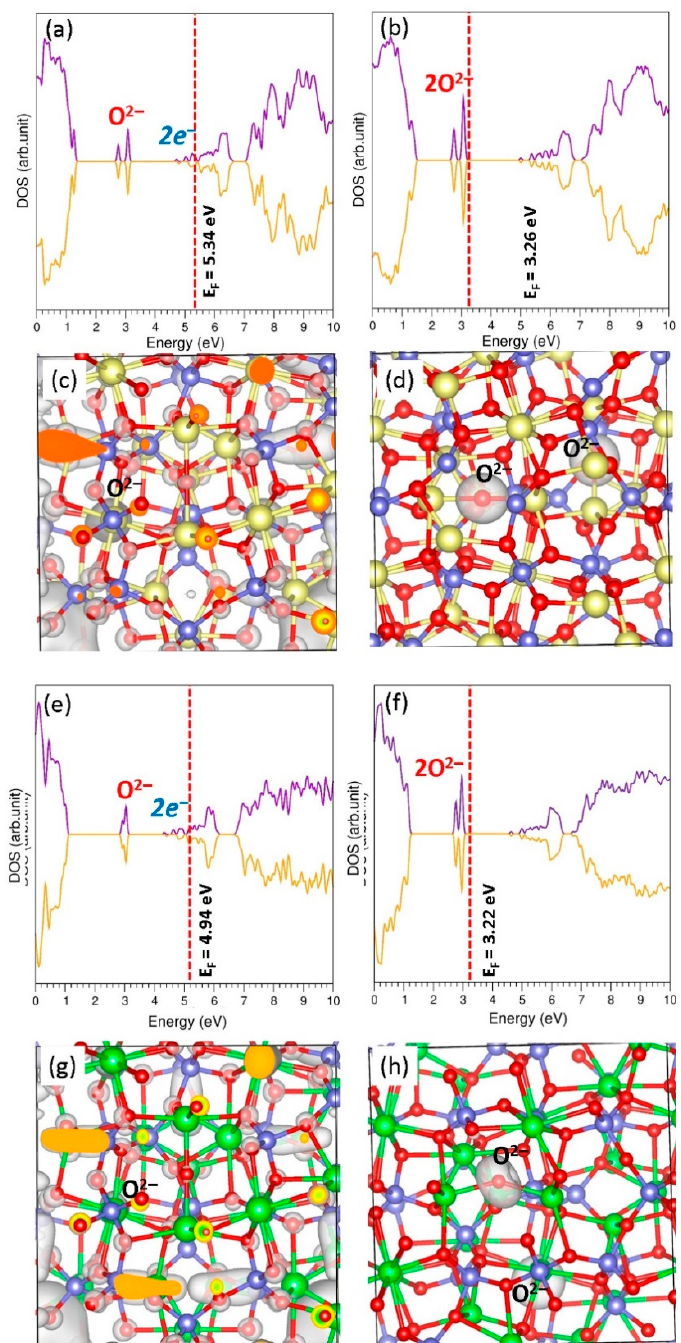
Figure 4. ( a , b ) Calculated DOS plots of C12A7:(e − ) 2 O 2 − and C12A7:(O 2 − ) 2 and ( c , d ) corresponding charge density plots associated with remaining extra-framework electrons and encapsulated oxygen atoms, respectively. Similar plots ( e – h ) are also shown for S12A7:(e − ) 2 O 2 − and S12A7:(O 2 − ).